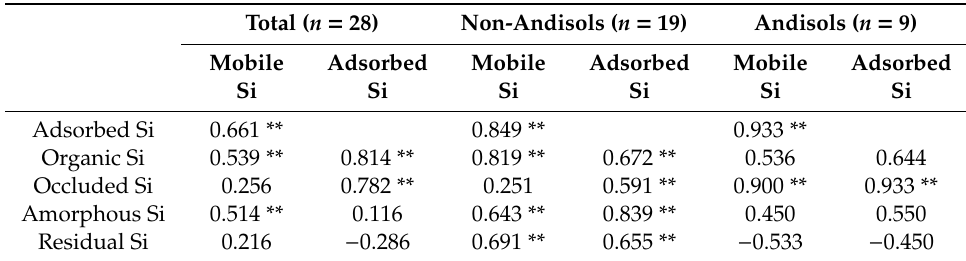
Table 6. Spearman’s rank correlation between readily soluble Si fraction (mobile Si and adsorbed Si) and potential sources in Si fraction (Si org , Si occ , Si ma